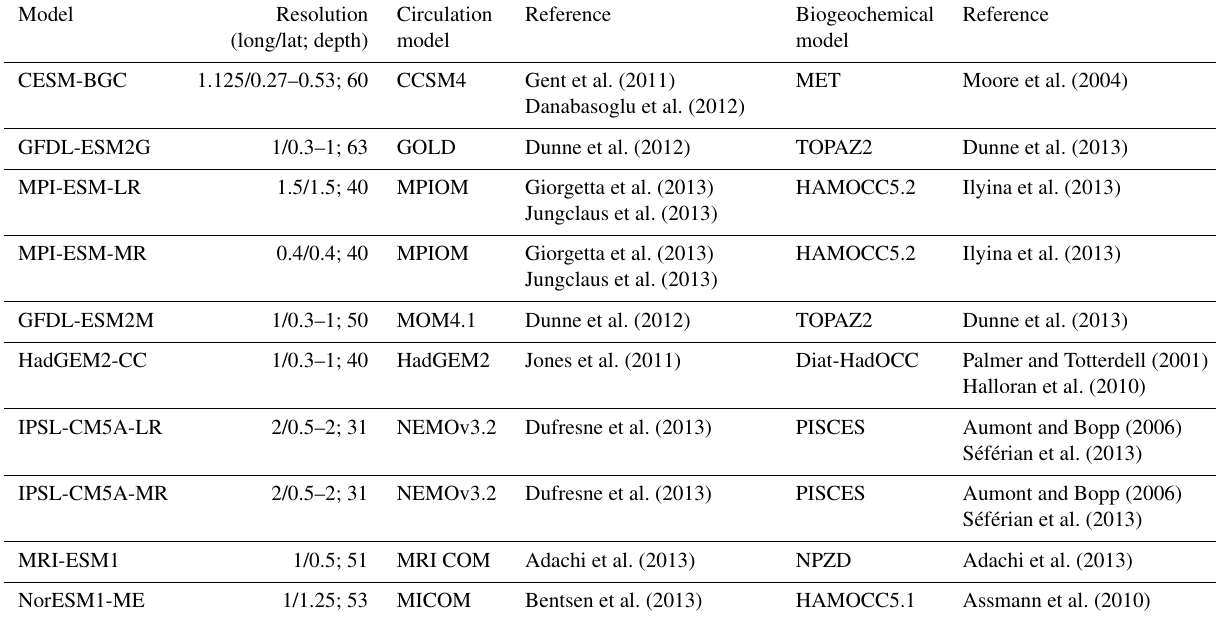
Table 1. Summarized information on CMIP5 ocean model components and respective references. IPSL-CM5A-LR and IPSL-CM5A-MR differ only in the atmospheric horizontal resolution, with similar ocean modules in both model